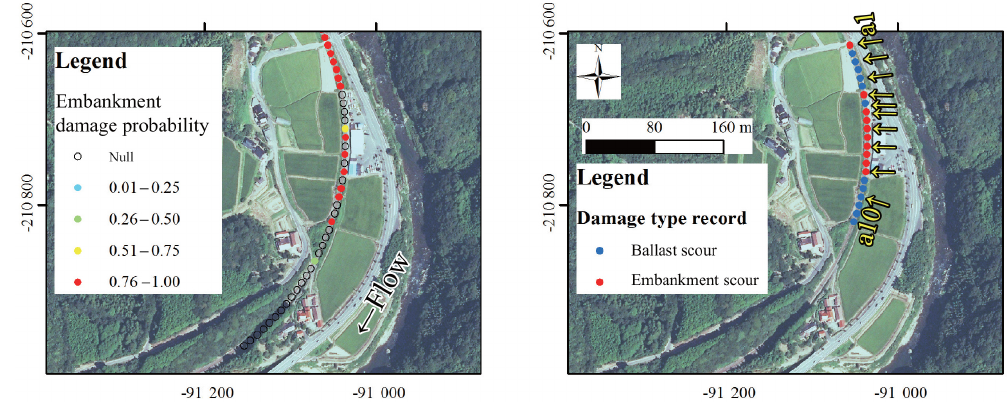
Figure 14. Estimated damage probability (left) and damage type record (right) at Asa River section M. The yellow symbols in the right map depict data points listed in Table